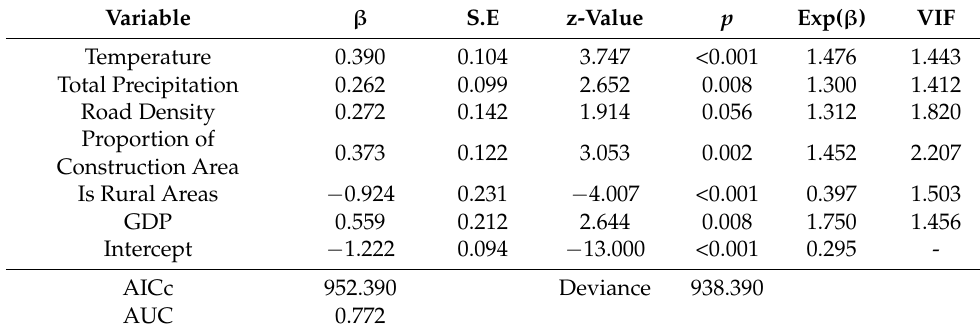
Table 3. Parameter estimates for the global logistic regression model.